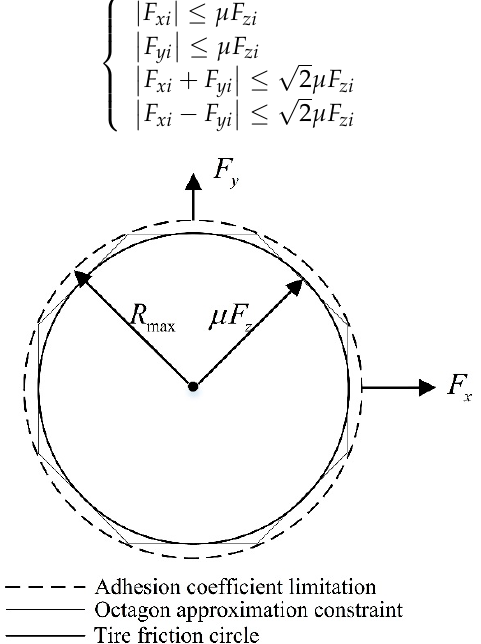
Figure 9. The schematic of linear polygon constraint.